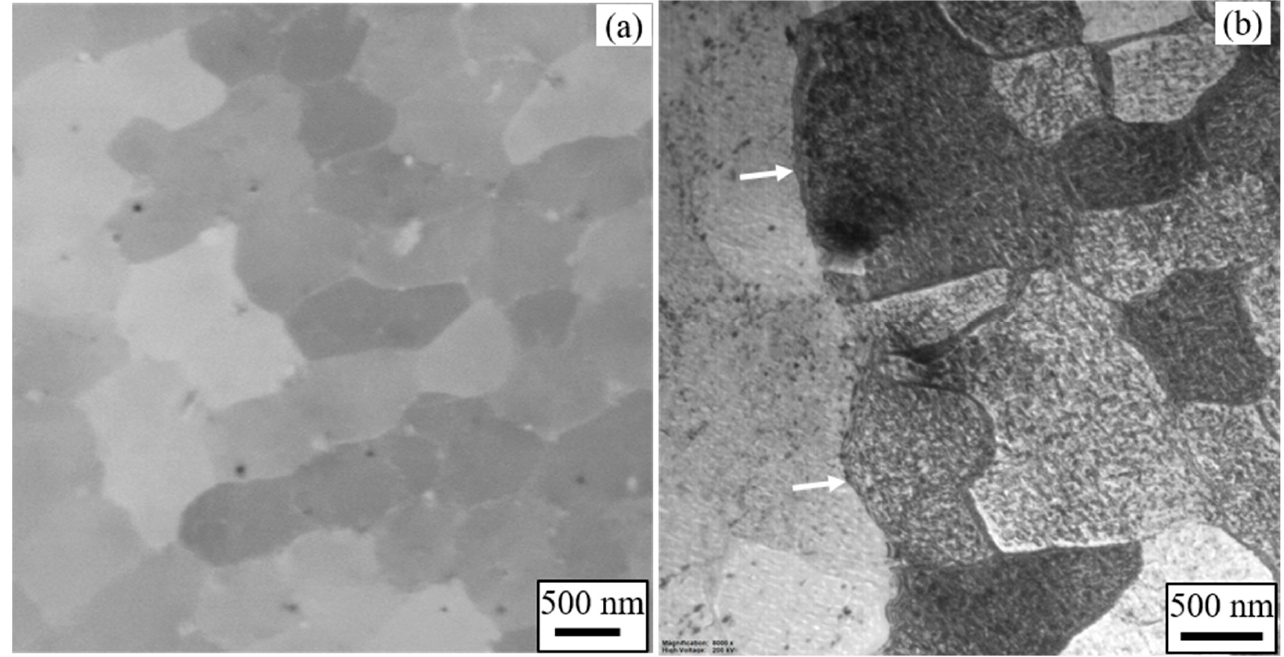
Figure 3. Subgrain boundaries after heat treatment ( a ) electron backscatter image of ST1 and ( b ) TEM BF image of STA3. The tiny white spots in the subgrain boundaries in ( a ) are the undissolved Laves/carbide phase. The arrows in ( b ) indicate a grain boundary. The rest are subgrain boundaries.